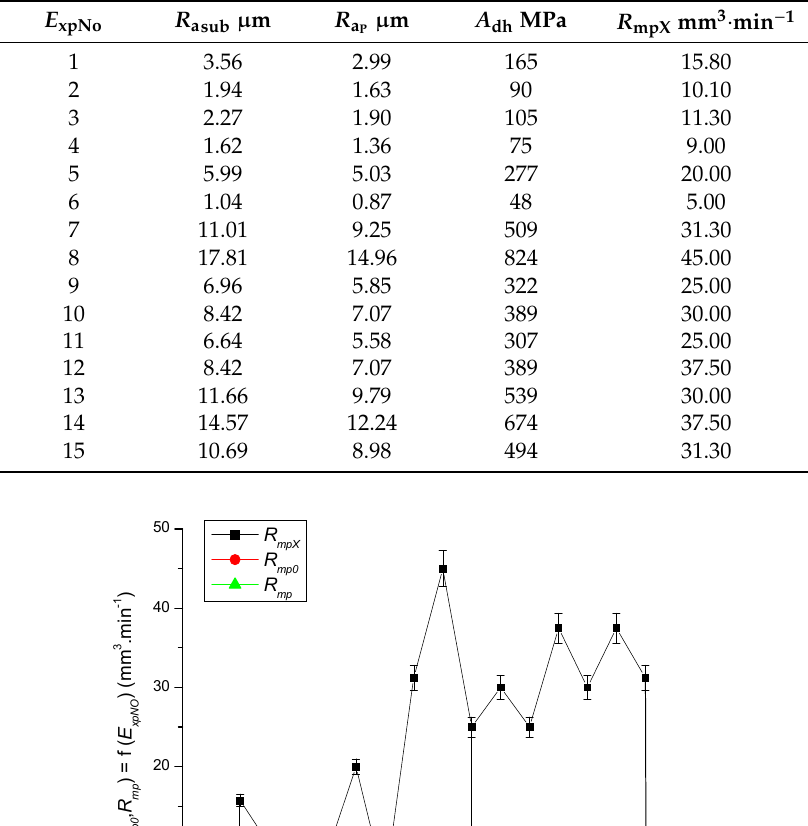
Table 5. Numerical comparison and verification of Vickers hardness.